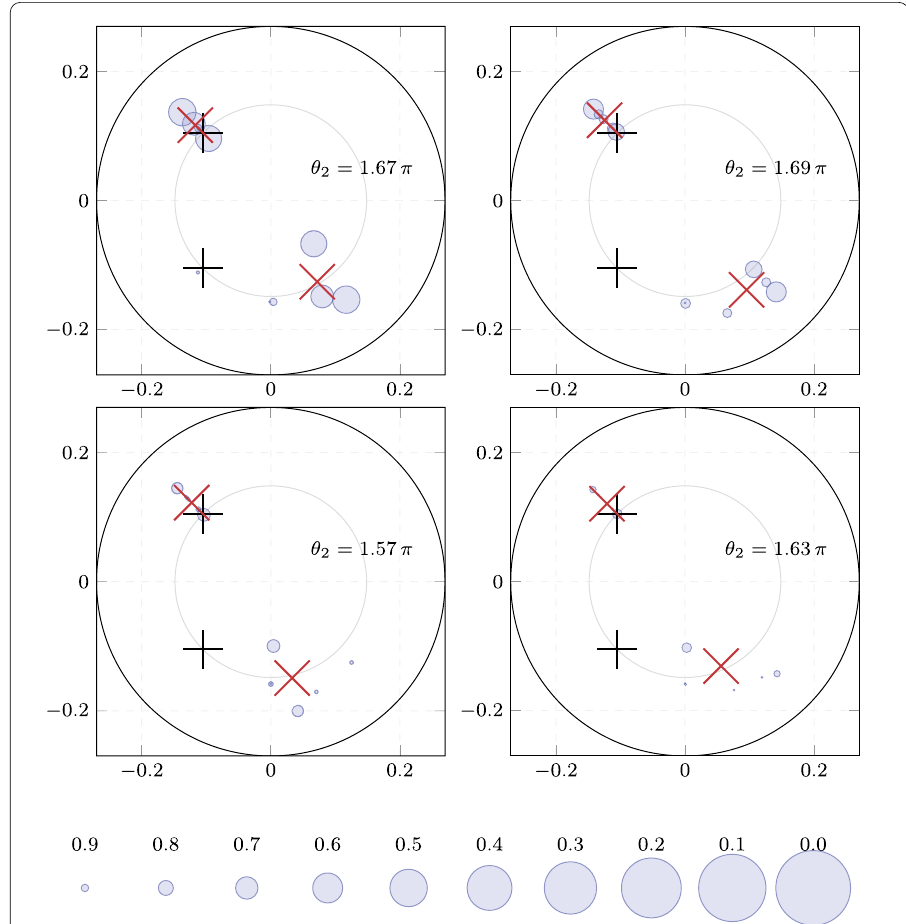
Figure 8 Optimization of nozzles’ positions. Results obtained on level 3 for J 3 (curl thr ) with curl thr ∈ { 1,10,25,50 } , top left to bottom right. The reduction of the functionals is depicted in accordance with the legend, i.e., the size of the circles represents 1 – R i with the corresponding reduction R i from equation (8). The red crosses are the computed weighted centers, see equation (9). The black plus